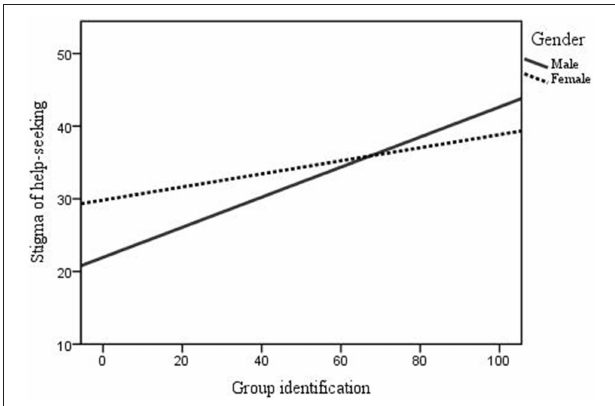
FIGURE 1 | Relationship between stigma of help-seeking and group identification for males and females.